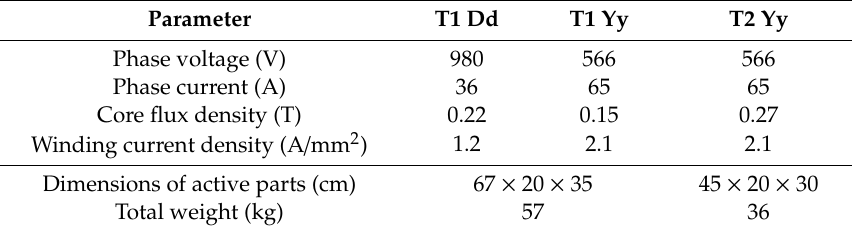
Table 1. Specification of the medium frequency transformer prototypes for the nominal operating conditions.